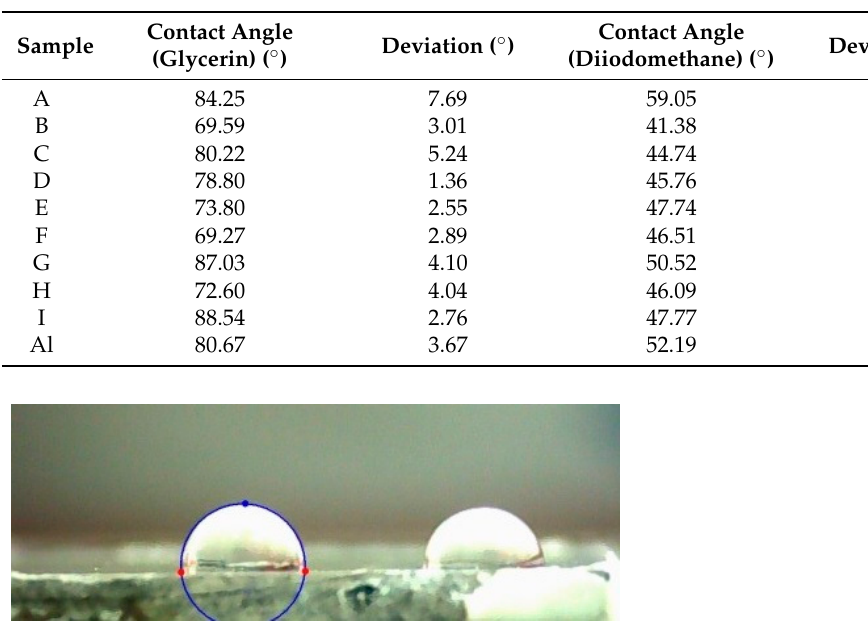
Table 7. Contact angles of oxide layers and aluminum alloy measured by glycerin and diiodomethane.